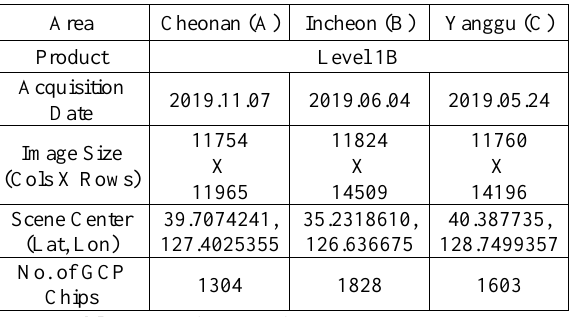
Table 2. Specification of RapidEye images